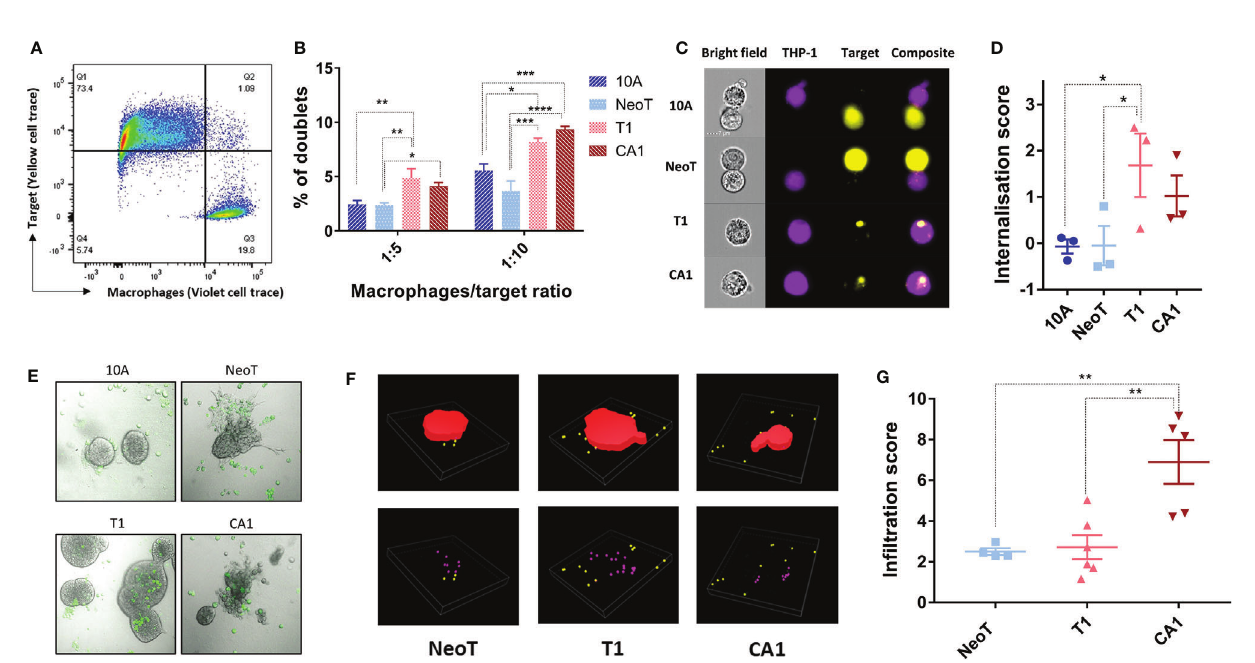
FIGURE 2 | De fi ning thresholds for macrophage phagocytosis of MCF cell lines in suspension and in fi ltration into 3-D clusters. (A) Example of the gating strategy to identify macrophage-MCF cell doublets. Macrophages and MCFNeoT cells were labeled with Paci fi c Blue and PE cell tracers, respectively. Doublets (Q2) were identi fi ed as PacBlue, PE double positive cells. (B) Percentages of doublets in 1:5 and 1:10 macrophage/MCF cell ratio as indicated MCF10A (10A), MCFNeoT (NeoT), MCFT1 (T1) and MCFCA1 (CA1). Results are presented as mean values ± SEM of four experiments. Fisher LSD test: ****p<0.0001, ***p<0.001, **p<0.01, *p<0.05. (C) Examples of images taken on the AMNIS 24h after coincubation of macrophages and indicated cells (1:20 ratio). Cells were labeled as in B and gating was on live cells. (D) Internalization scores were calculated using the Internalization function in IDEAS 6.2. Results are presented as mean values ± SEM of three experiments. Fisher LSD test: *p<0.05 . (E) Representative images of macrophages contacting MCF10A (10A) and MCFNeoT (NeoT); in fi ltrating MCFT1 (T1); destroying MCFCA1 (CA1) cell clusters. Macrophages were labeled with FITC (green) and added on top of cells in 3-D clusters grown in Matrigel. (F) Examples of 3- D reconstructions from z-stacked images using the NIS-Element software. 3-D clusters are represented in red, non-in fi ltrating macrophages in yellow and in fi ltrating macrophages in pink. (G) In fi ltration score was calculated as the number of in fi ltrating macrophages divided by the cluster volume as described in Materials and Methods. Results are presented as mean values ± SEM of 4 clusters for MCFNeoT, 6 for MCFT1 and 5 for MCFCA1. Fisher LSD test: